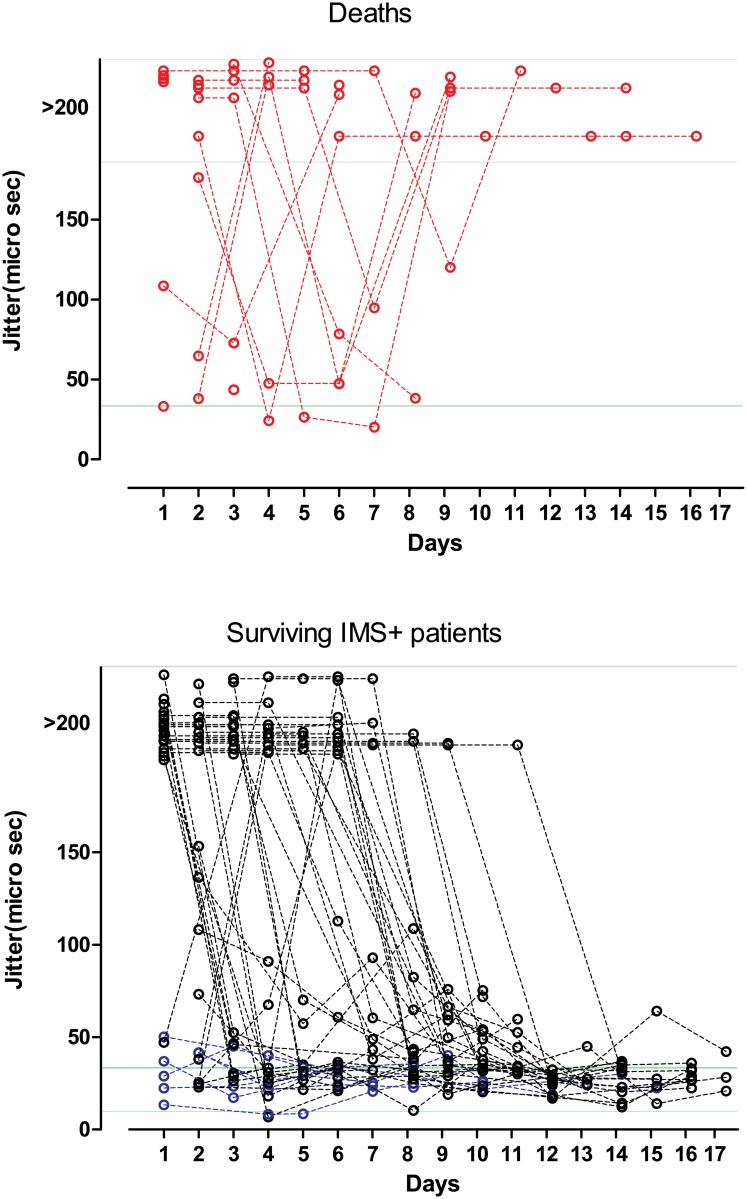
Variation of jitter over time in patients who died and those who survived with IMS over time.(Green represents the range of normal jitter and grey represents jitter >200 μs).